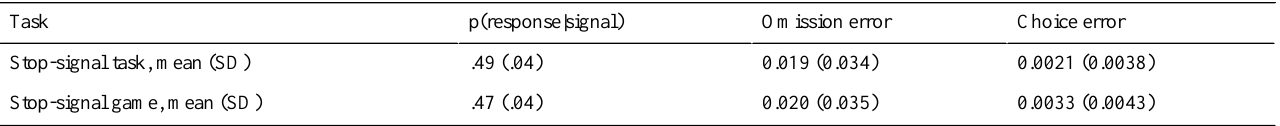
Choice errorOmission